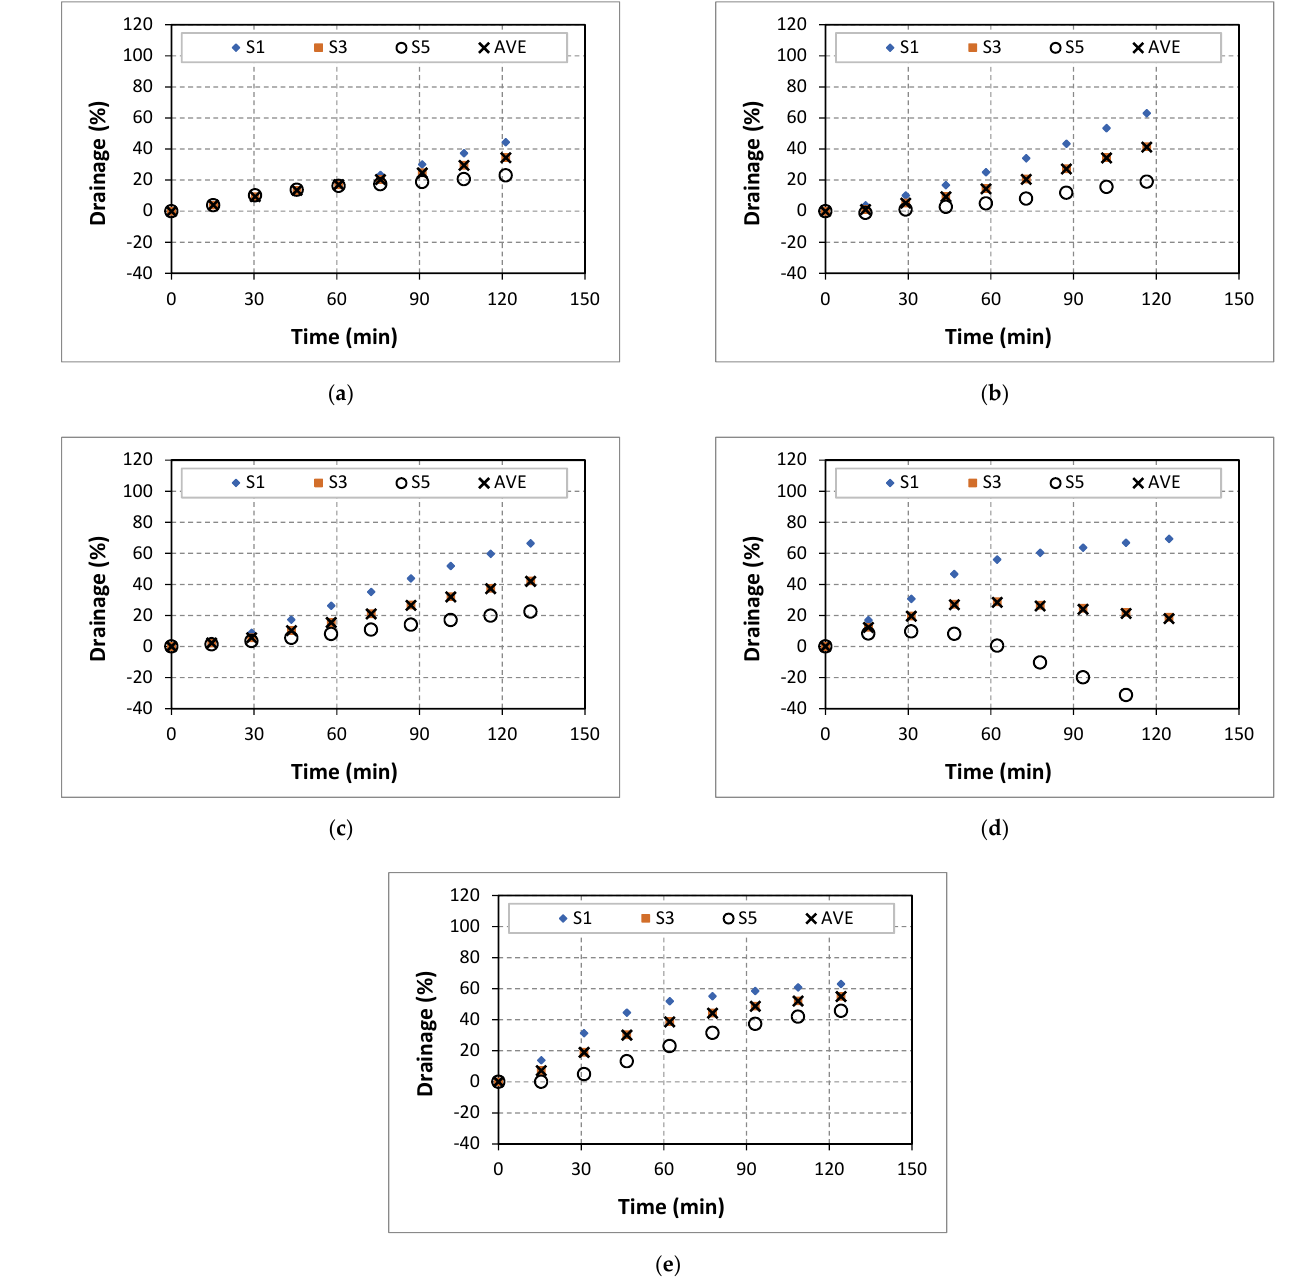
Figure A4. Drainage of 60% quality aqueous foam at different CaCl 2 concentrations: ( a ) 0% wt., ( b ) 5% wt., ( c ) 7% wt., ( d ) 9% wt., ( e ) 14% wt.